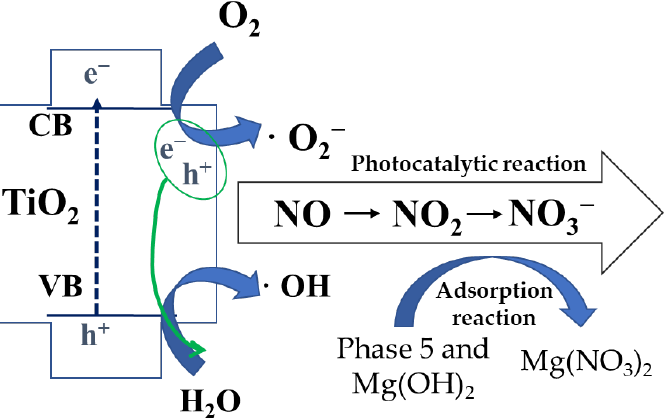
Figure 9. Schematic image of the photocatalytic reaction process for PPMOC to NO-NO 2 -NO x (CB—conduction band; VB—valence band; e − —electron; h + —electron hole).